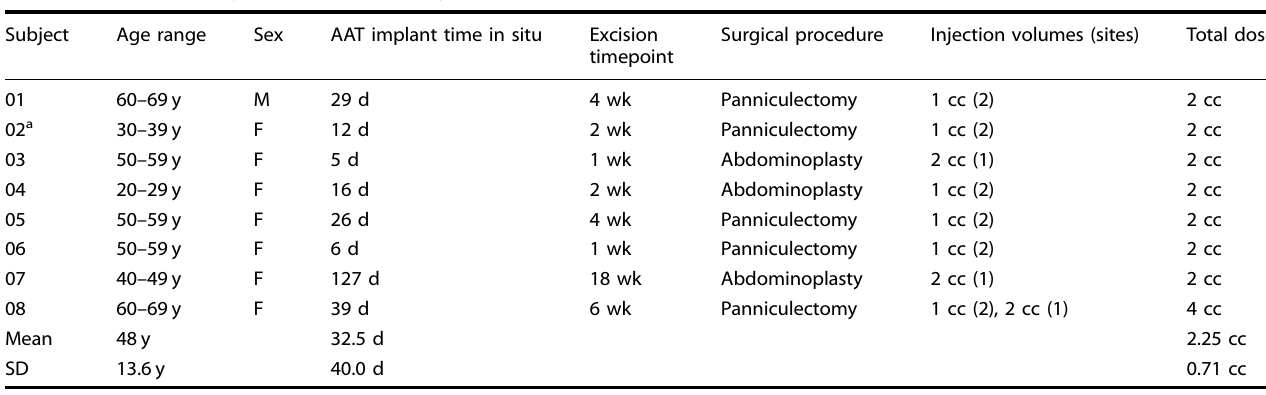
Table 1. Subcutaneous injection of AAT in healthy